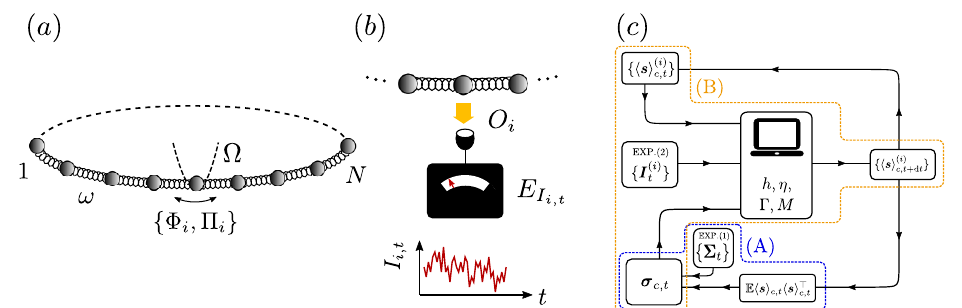
Figure 1: (a) Lattice regularization of the free boson CFT. (b) Schematic picture of measurement of operator O located on size i and the associated weak measurement i operator E . The measurement outcomes are distributed following a Wiener process I i , t 〉 around the conditioned expectation value 〈 O . (c) Sketch of the algorithm how to i c , t reconstruct the conditioned density matrix ρ . We assume that in experiment 1 (2) c , t } ( { I ( i ) } ) were measured. Given the 〈 s 〉 ( i ) for the present (initial) the quantities { Σ t c , t t time the conditioned covariance matrix σ is reconstructed according to Eq. (22) c , t ( i ) [ see dashed box (A) ] . From the present 〈 s 〉 ( i ) and σ together with I , we construct c , t c , t t 〈 s 〉 ( i ) by numerically applying the recursion Eq. (71) for every experimental run c , t + d t i [ see dashed box (B) ]